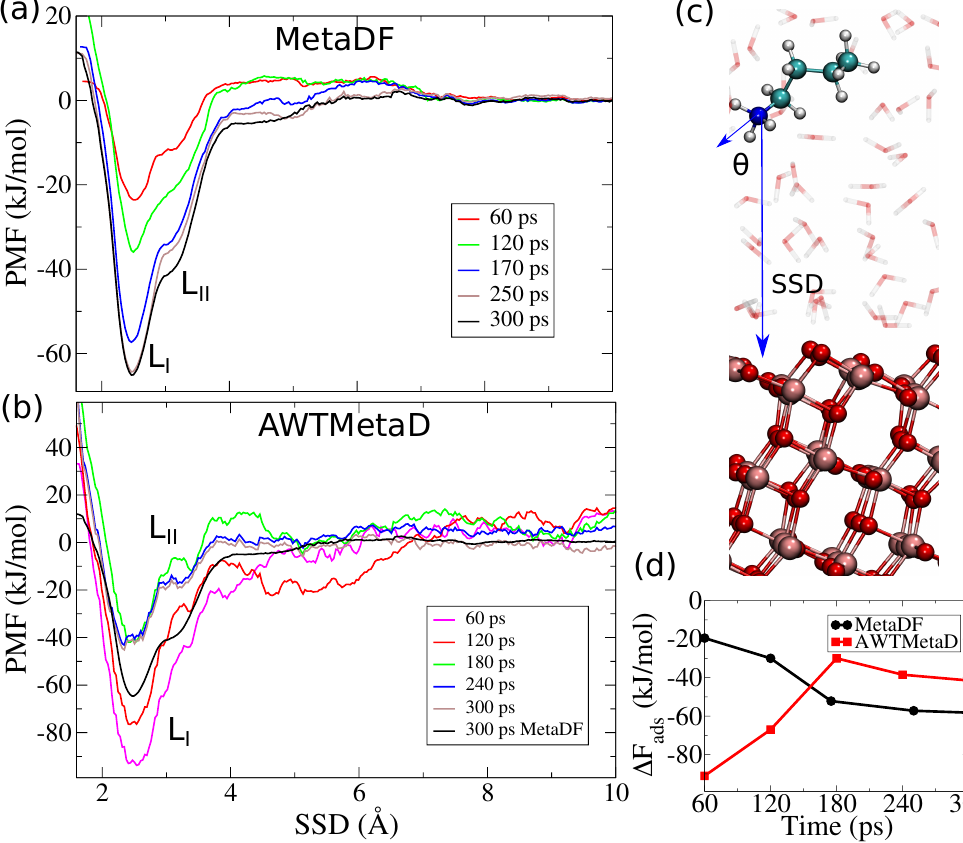
Figure 3. Potentials of mean force (PMFs) for Lysine on anatase (101) along the surface separation distance (SSD), calculated with ( a ) MetaDF and ( b ) AWTMetaD. The PMF converges to an error of 3kJmol − 1 (as estimated from the force variance [57] and the convergence profile ( d )) within 250 ps of MetaDF, but fails to converge after 300 ps of AWTMetaD. The reported times are per walker, with eight walkers per calculation. ( c ) A representation of the two CVs used to sample the free energy landscape. θ is the angle between the normal vector to the TiO 2 surface and the vector N − C fn . ( d ) ∆ F ads as function of time. MetaDF converges asymptotically after 250 ps but AWTMetaD does not converge within 300